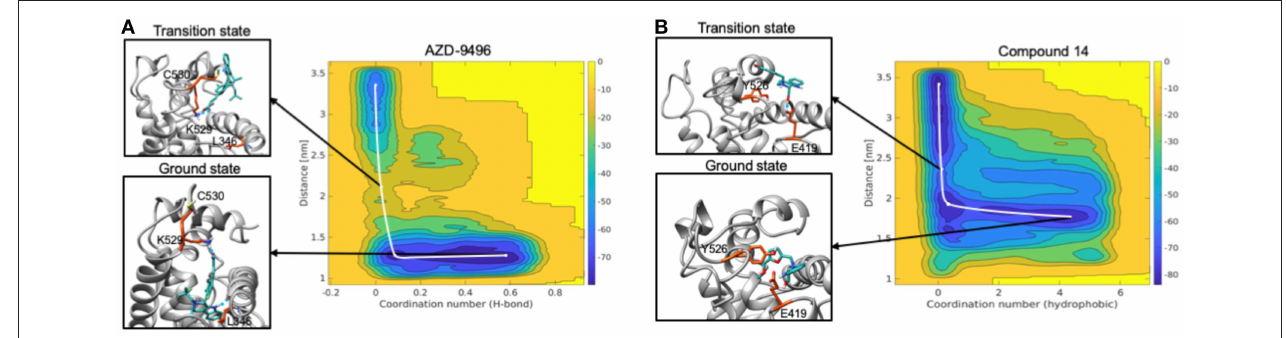
FIGURE 9 | Free energy surface maps from metadynamics simulations for the dissociation of AZD (A) and compound 19 (B) from the ligand binding cavity. On x axis is coordination number (H-bond for AZD and hydrophobic interactions for 19 ) and on y axis is COM distance between ligand and receptor. Color scale represents free energy values in kJ/mol. In black squares are encircled structures corresponding to the ligand bound state (ground state), the transition state.